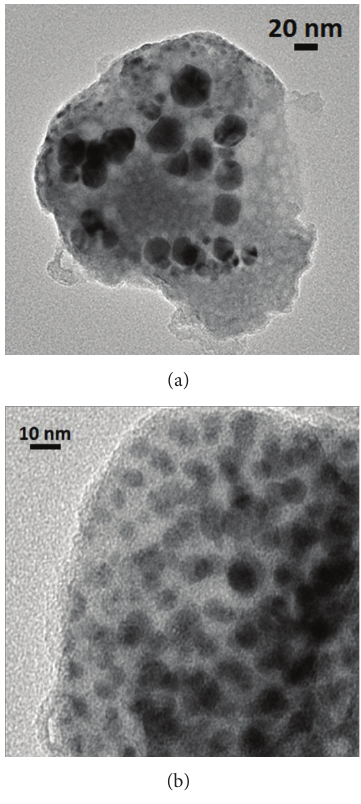
Figure 4: TEM image of the Eu 3+ doped samples: (a) GeO 2 -PbO glass with silver NPs heat-treated for 72 hours, (b) GeO 2 -Bi 2 O 3 glass with gold NPs heat-treated for 24 hours [1].